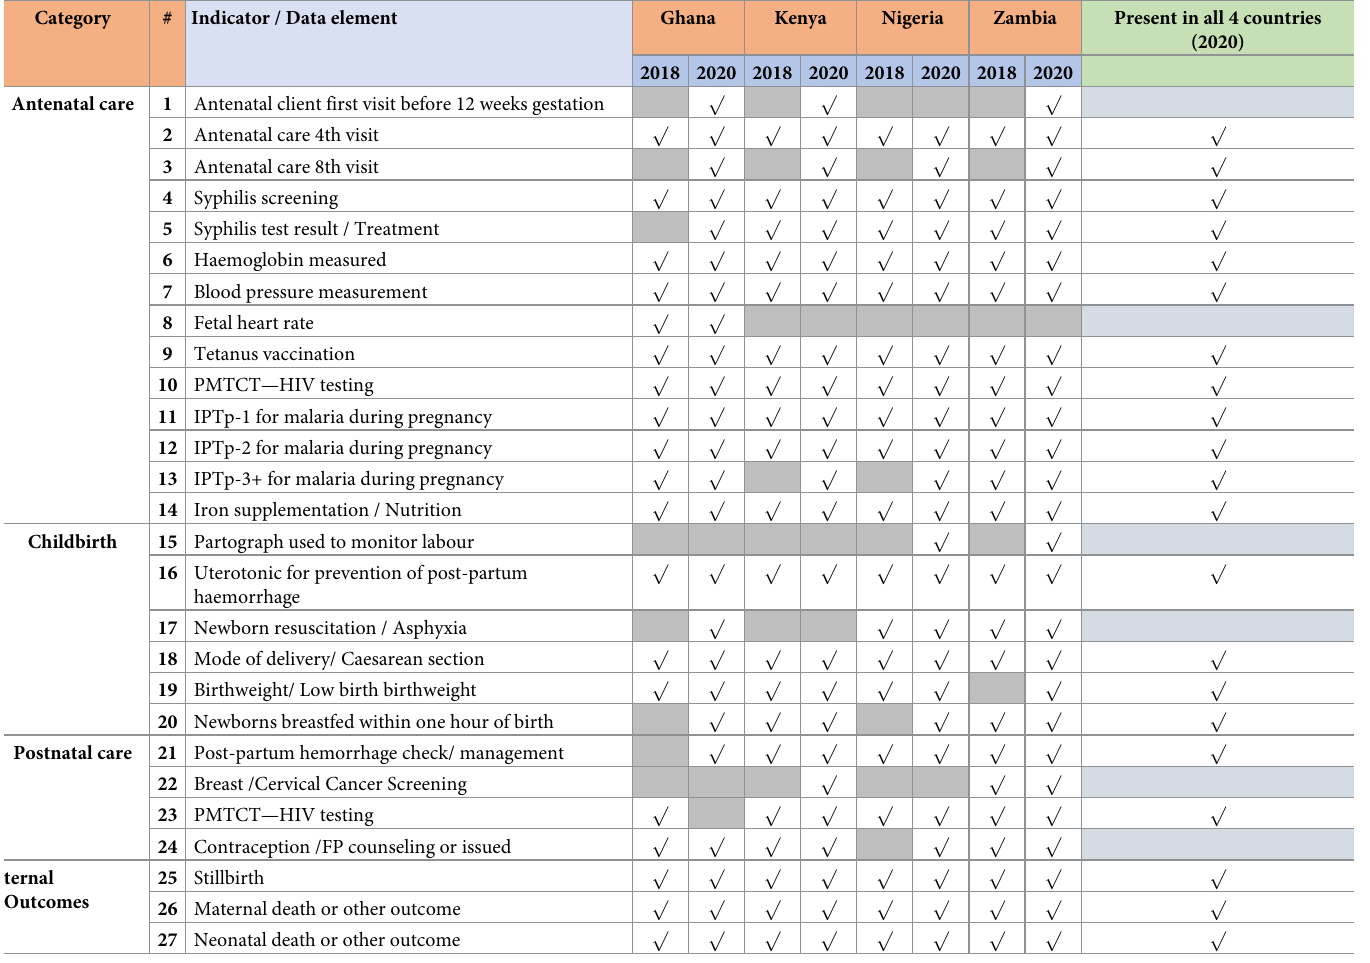
Table 9. Comparison of 2018 to 2020 register review from four countries.